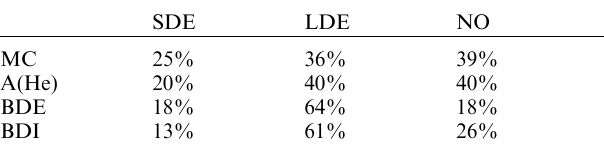
Table 6. The X-ray association of IP signatures